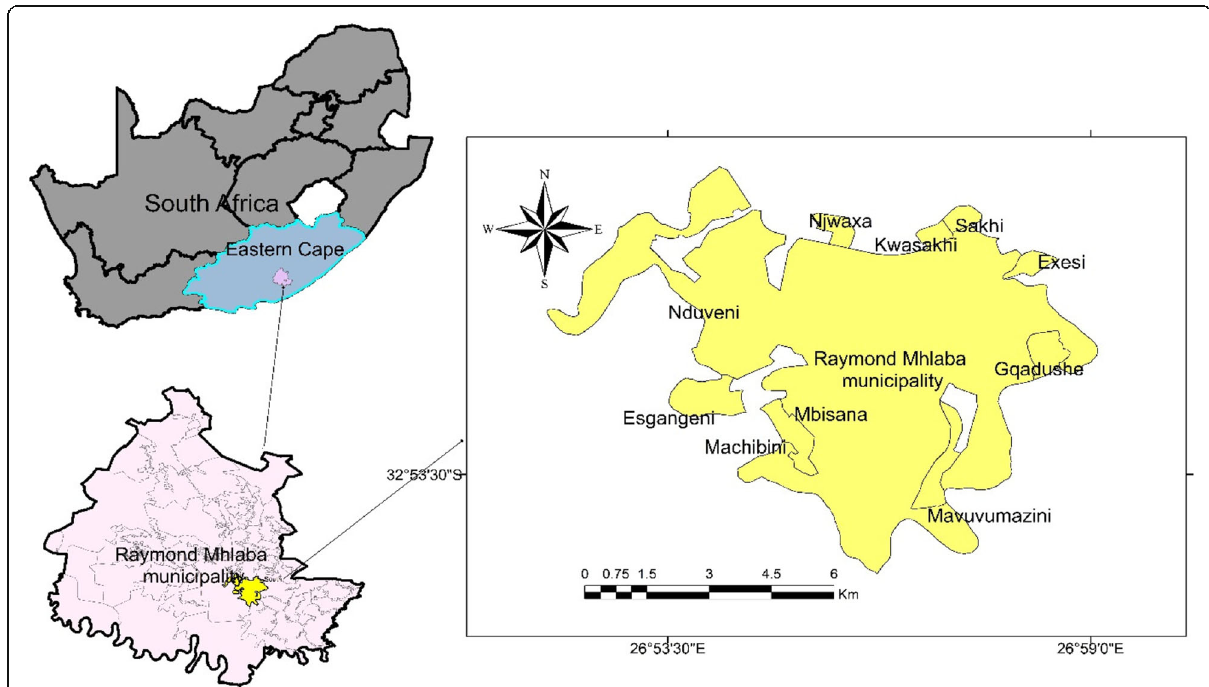
Fig. 1 Map showing the different villages used for the